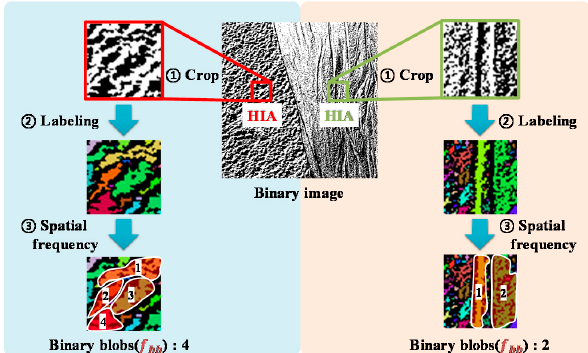
Figure 4. Examples of determining the beat frequency.